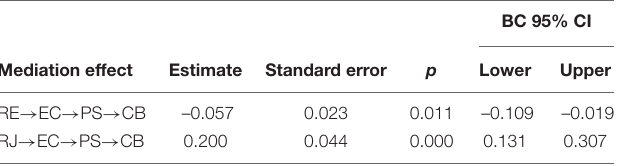
TABLE 4 | Bootstrapping results of serial mediation effects (Based on the most impressive service recovery experience).